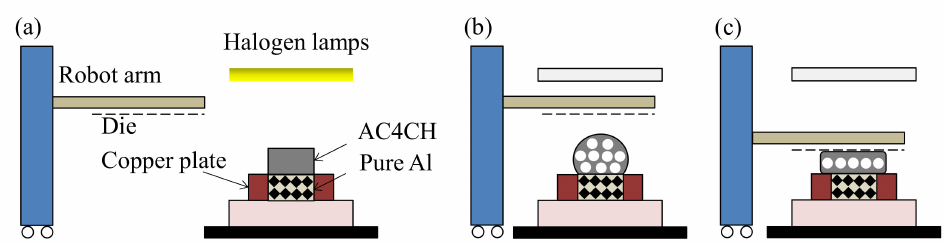
Figure 2. Schematic illustration of foaming and press forming. ( a ) Start of heating. ( b ) Insertion of forming die after foaming and end of heating. ( c ) Press